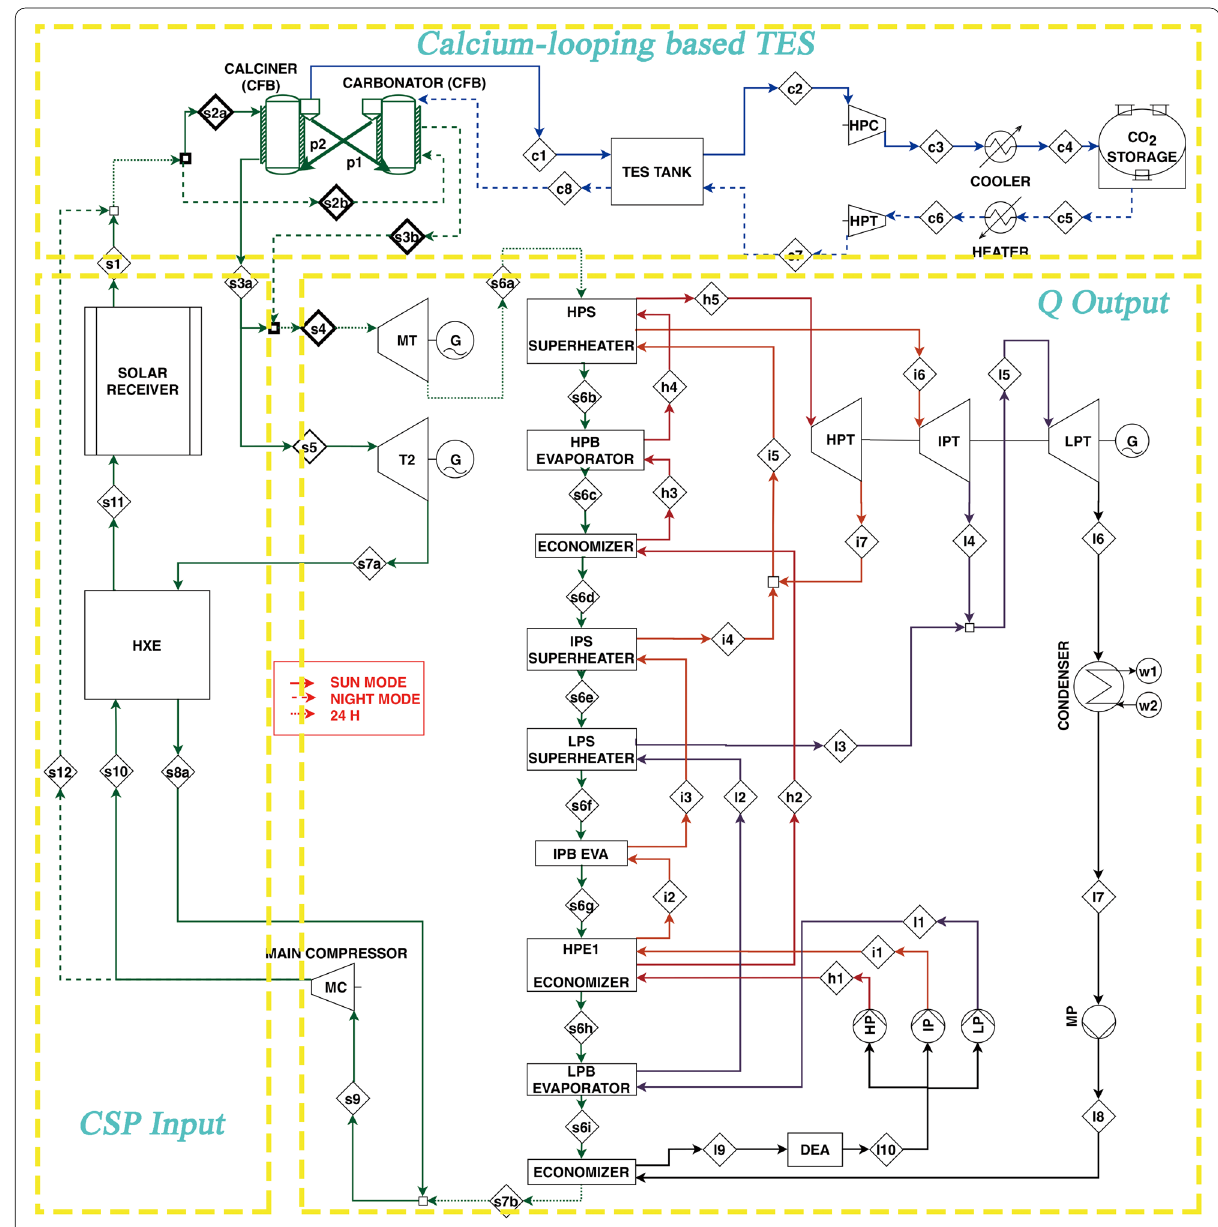
Fig. 24 Detailed scheme of the CSP plant with calcium-looping in the combined cycles